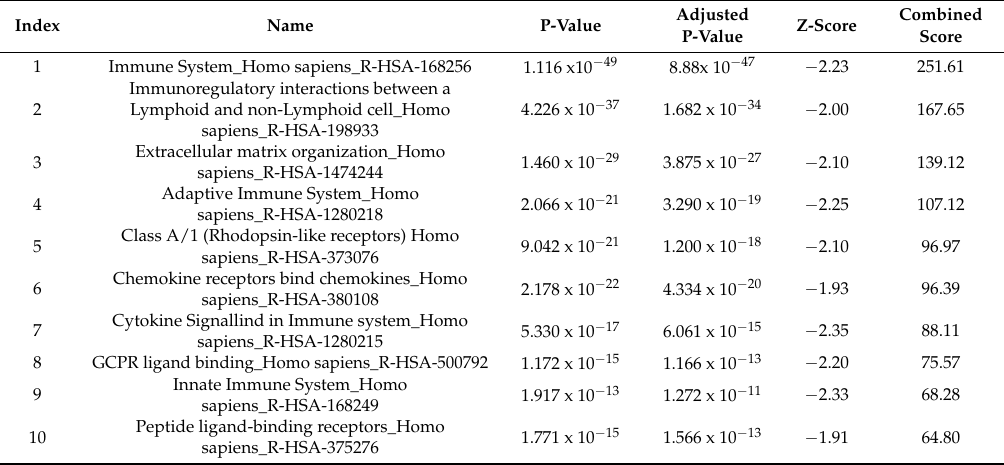
Table 1. Gene with increased transcript levels in cluster associated with poor